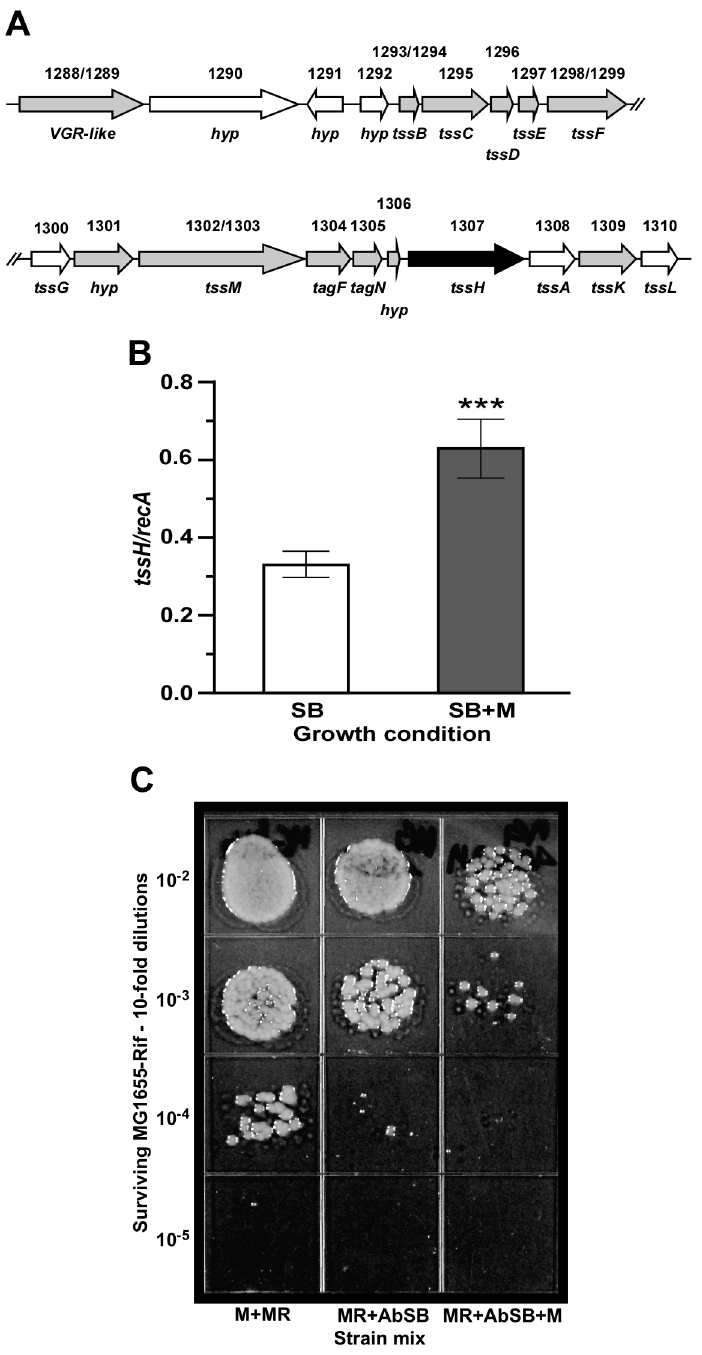
Fig 7. Differential transcription of genes coding for T6SS components in response to the presenceof mucin. (A) ATCC 19606 T genes codingfor T6SS components. The arrows represent each codingregionand its directionof transcription. The white and grey arrows represent genesconstitutivelyand differentially expressedin responseto the presenceof mucin, respectively. The black arrow indicates tssH (A1S_1307), which was used to confirm the mucin-mediated up-regulation effect by qRT-PCR. Numbers above the arrows representcognate A1S_ gene annotation numbers, and gene names are indicatedbeloweach arrow. Coding regions A1S_1288/1289, A1S_1293/1294, A1S_1298/1299, and A1S_1302/1303 are each representedas a singlecoding regionsince potentialnucleotide sequencing errors could have resultedin the annotationof multipleopen readingframes. hyp , genecoding for a hypothetical protein. (B) qRT-PCR analysisof the differential expression of A1S_1309in bacterialcells cultured in SB (white bar) or SB+M (grey bar)